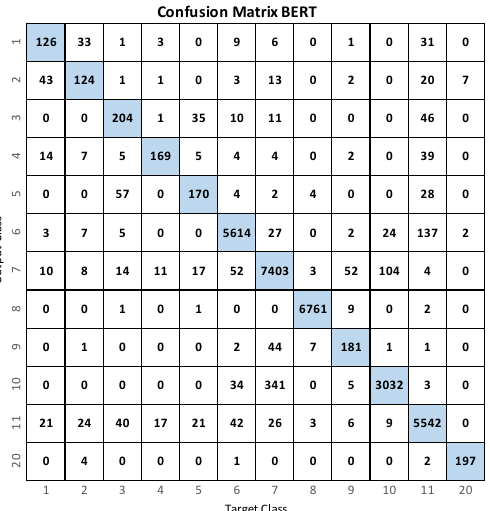
Figure 5. Confusion matrix for the recognition of activities with